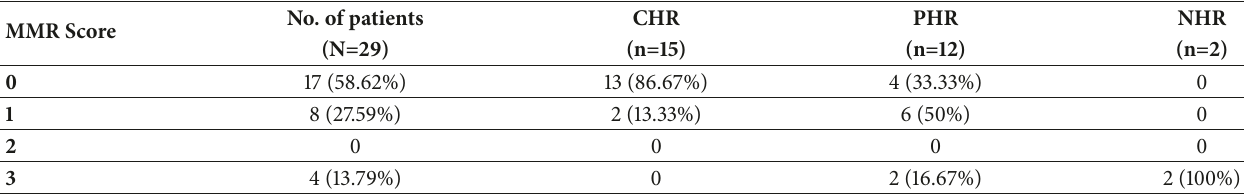
Table 4: Correlation of marrow morphological response (MMR) score with hematological response.